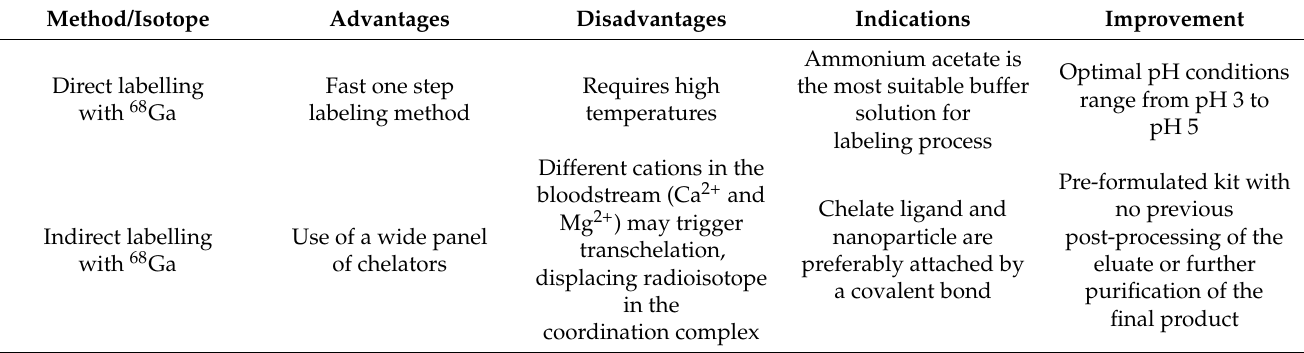
Table 2. Pros and cons of different methods for radiolabelling NPs with